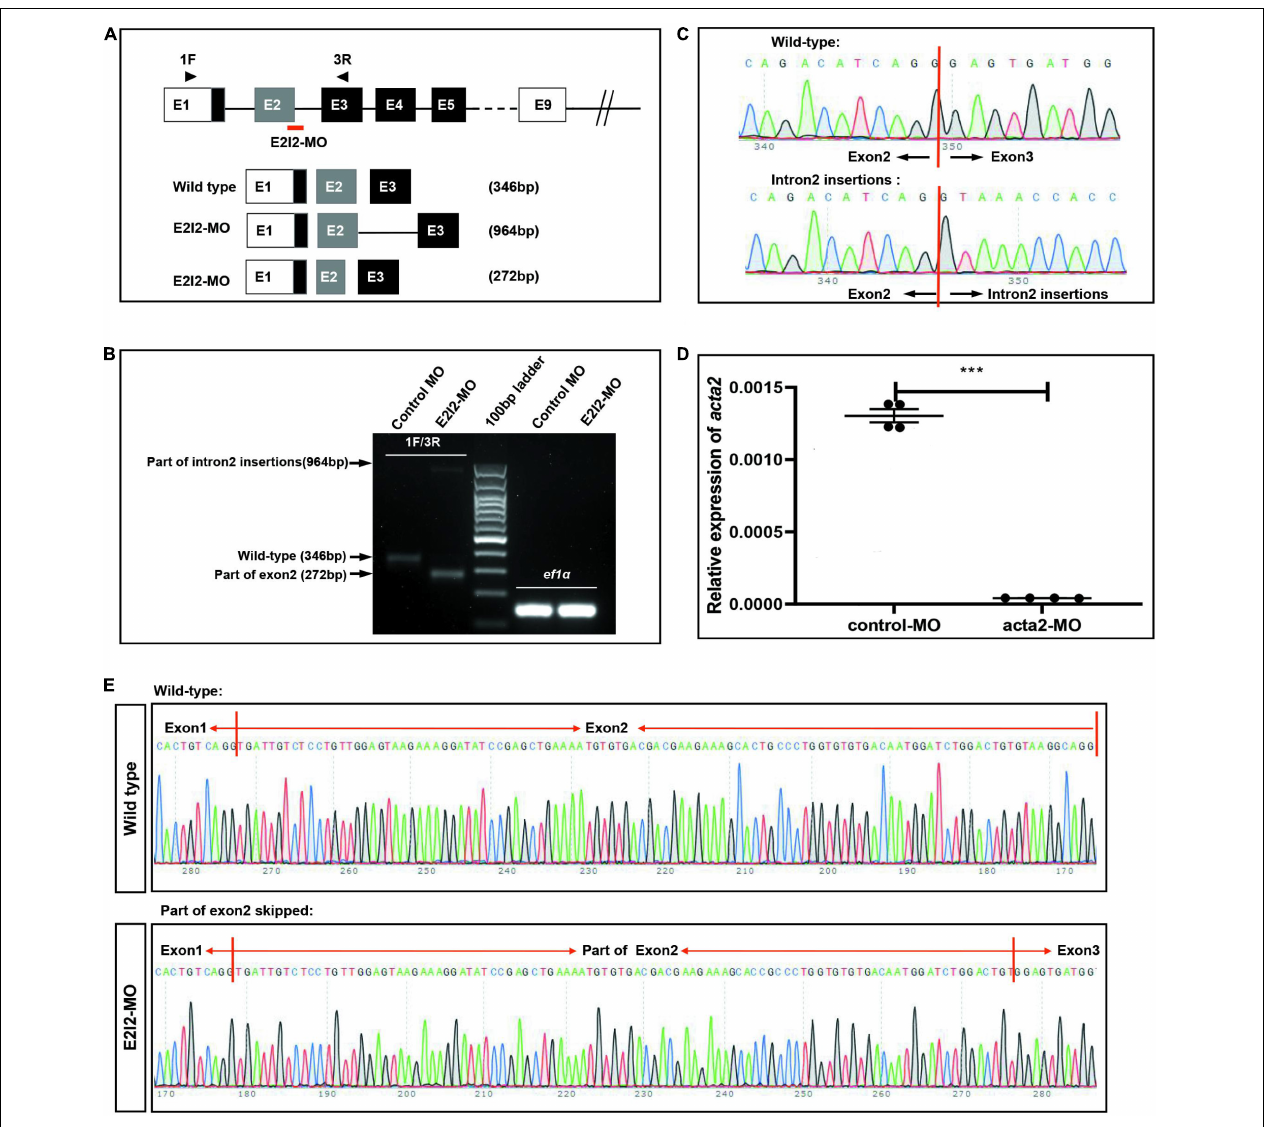
FIGURE 6 | Effectiveness of acta2 knockdown was confirmed by RT-PCR and qRT-PCR. (A) The zebrafish acta2 gene was targeted by specific morpholino antisense to prevent proper splicing of exon 2 (E2I2-MO). (B) RT-PCR of acta2 transcript from control-MO and E2I2-MO morpholino-injected embryos 2 days after fertilization, demonstrating insertion of intron 2 and skipping of exon 2. (C,E) Sanger sequencing of both the wild type band and the intron 2-inserted band and the exon 2-skipped band validating the wild type sequence and the intron 2-inserted sequence (C) and the exon 2-skipped sequence (E) . (D) Quantitative measurements of acta2 expression levels measured by qRT-PCR (*** P < 0.0001). MO-targeted down-regulation of acta2. dpf, days